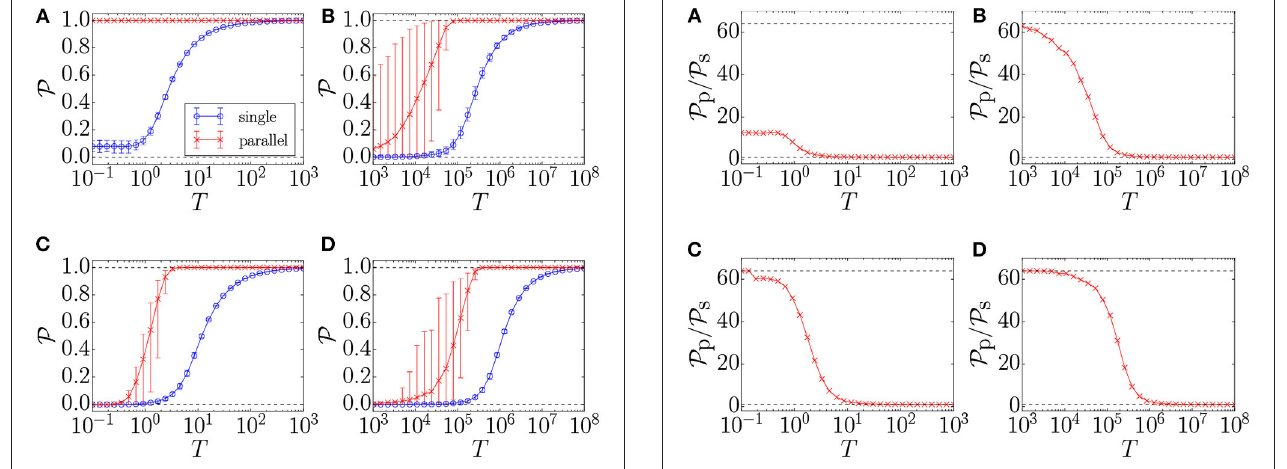
FIGURE 2 | Ratio of the mean parallel-trial acceptance probability ( P p) to the mean single-trial acceptance probability ( P s) vs. the temperature ( T ), for four problem classes: (A) 2D-bimodal, (B) 2D-Gaussian, (C) SK-bimodal, and (D) SK-Gaussian. A constant-temperature Monte Carlo simulation has been run for 10 5 sweeps to thermalize, after which the acceptance probabilities are measured for 5 · 10 3 sweeps. For each problem class, the simulation has been performed on 100 problem instances of size N = 64 with 10 repeats per problem instance. The upper horizontal dashed line indicates N , the number of variables, which is the expected theoretical value of the ratio at low temperatures, as given by Equation 3 divided by Equation 1. The lower horizontal line indicates the minimum value of the ratio, which is